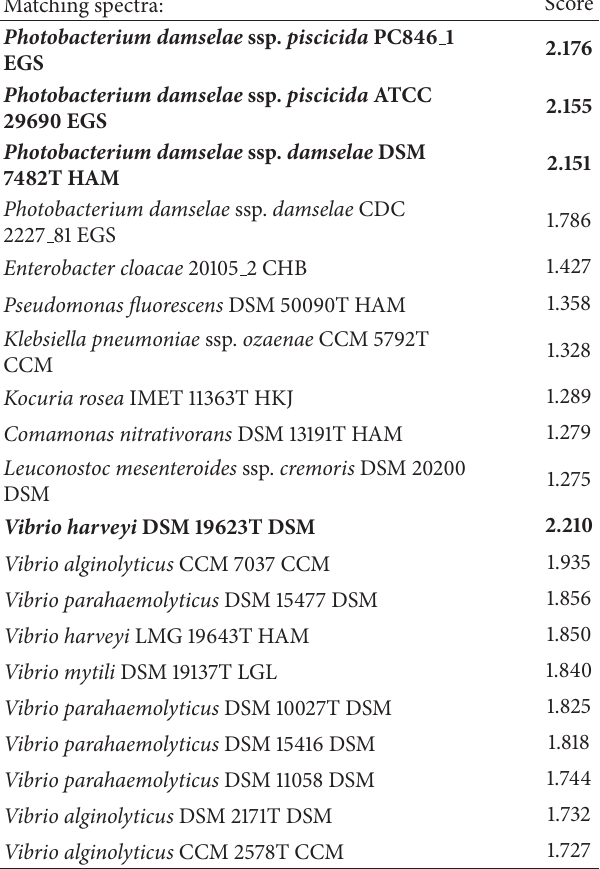
Table 1: MALDI-TOF identification results obtained for P. damselae and V. harveyi . Note that the number of available spectra in the database is 4 for P. damselae (two for each subspecies) and 4 for V. harveyi . MALDI scores equal or higher than 2.000 allow for the designation of a species while below 2.000 but equal or above 1.700 allow for the designation of a genus. By default, 10 hits per identification are provided. Hits with scores in support of the final identification are given in bold. The installed database was V3.3.1.0 4110-4613 as of August